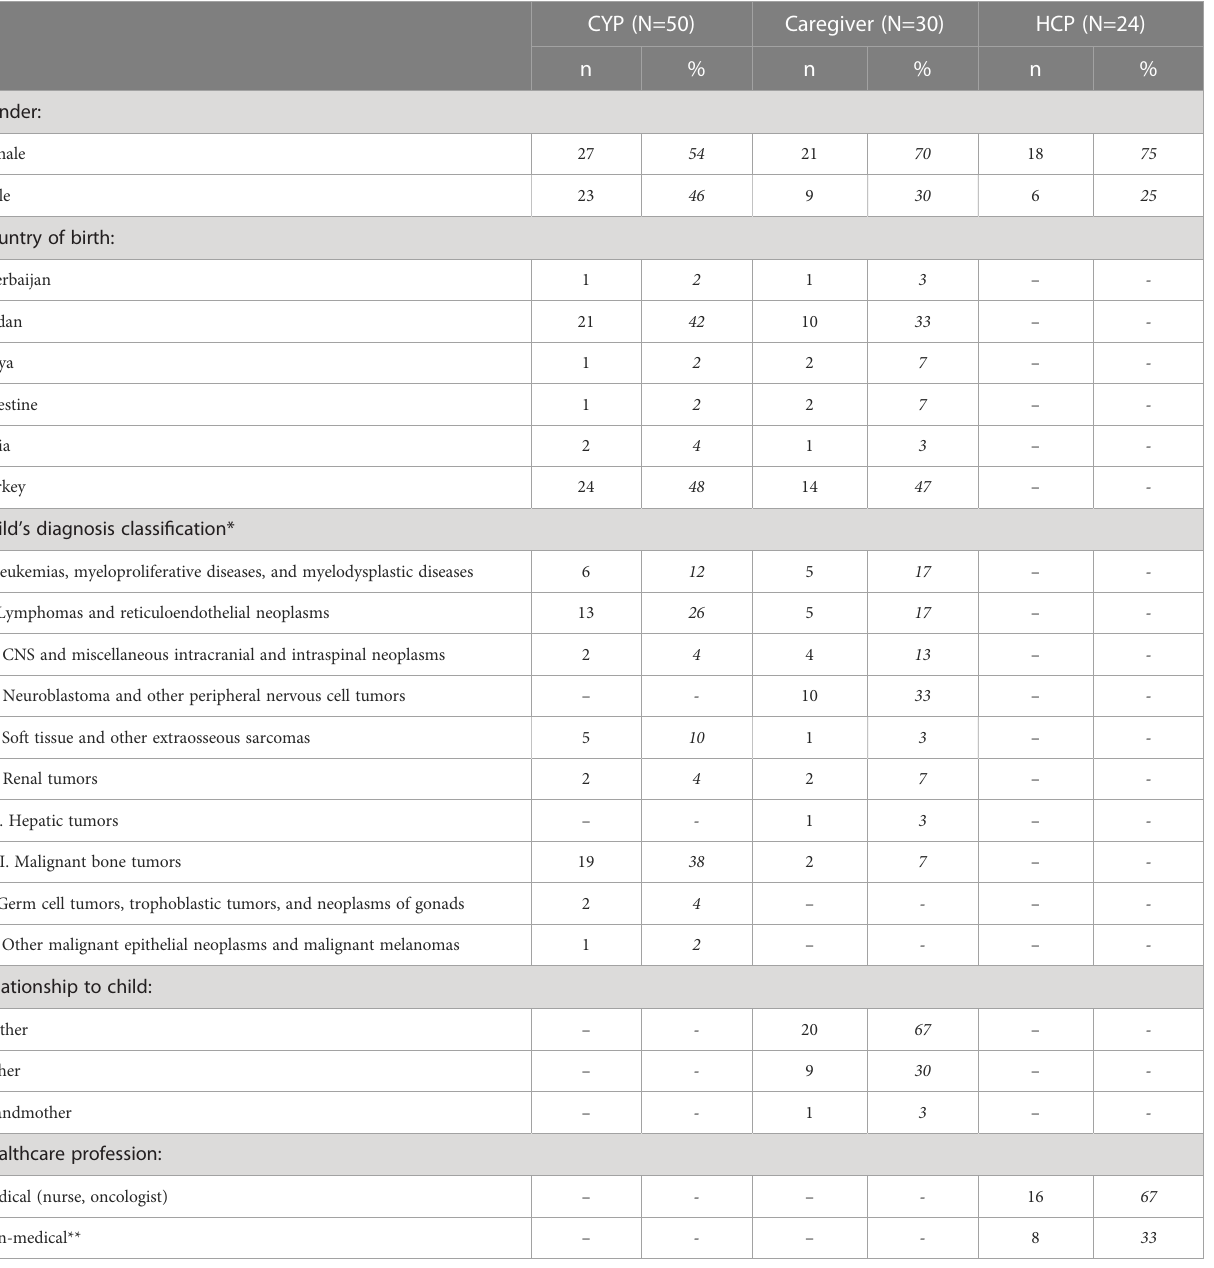
TABLE 2 Participants ’ characteristics